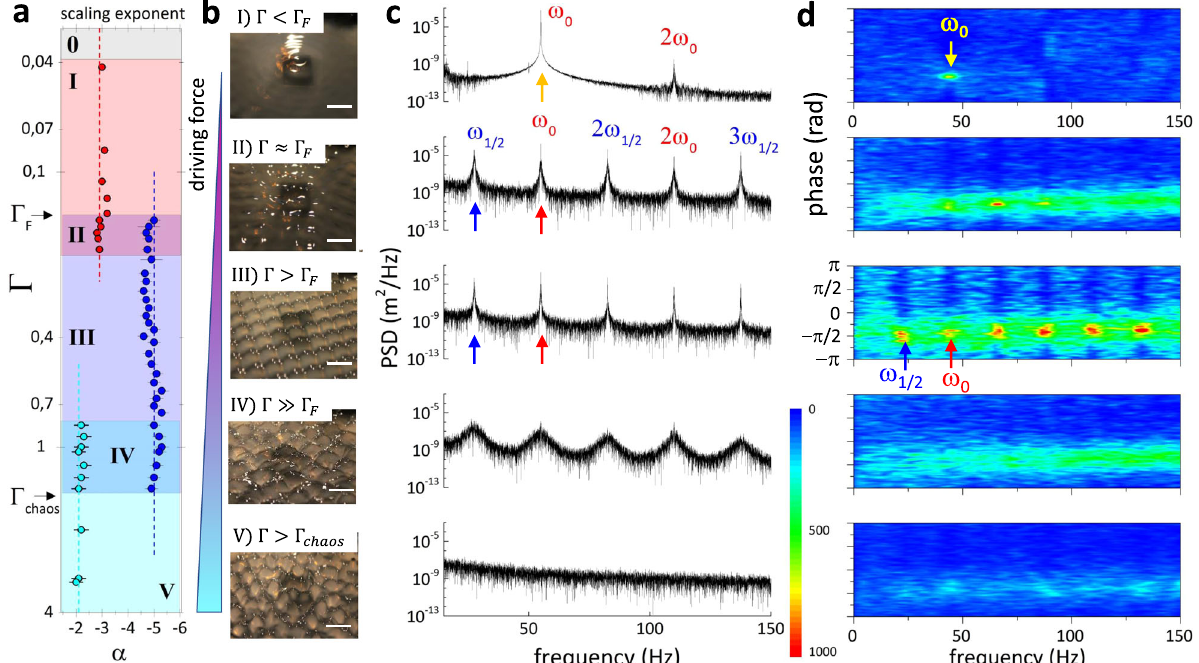
Fig. 4 Hydrodynamic crystals: structured cascades and wave coherence. a Scaling exponent ( α ) obtained from the complete spectral cascades (see Supplementary Fig. 9) for increasing driving force (from red to blue), highlighting the transitions between the waving states qualitatively delimitated by different color areas (as in Fig. 2c). The error bars correspond to the fi t uncertainty. b Imaging of the nonlinear surface waves at the center of the vessel for different Γ , corresponding to the subsequent spectral analyses performed, and at ω 0 = 47 Hz in the capillary regime. c Power spectral density (PSD), and d phase distributions at increasing amplitude (spectral zooming at the fundamental modes and fi rst harmonics; from top to bottom): (I) Weak KZ- turbulence ( Γ < Γ F ) exhibiting only the harmonic cascade, small coherence between the peaks and a disordered surface. (II) Hybrid KZF-cascade at the onset of the Faraday regime ( Γ ≈ Γ F ), where the subharmonic cascade at ω 1/2 emerged, the peaks acquired a higher degree of coherence and the surface displayed a waving pattern but still not ordered. (III) Pure Faraday waves in the regime 1.5 Γ F ≲ Γ ≲ 4 Γ F , where the peaks narrowed, exhibiting a strong coherence, and the Faraday waves froze as a stable square pattern. (IV) For increasing acceleration ( Γ F ≪ Γ < Γ chaos ) the peaks broadened and decoherence broke up the crystal. (V) In the complete chaotic regime ( Γ > Γ chaos ), nonlinear surface wave-spectra did not show any peak, the phase distribution was random, and the waving surface became strongly